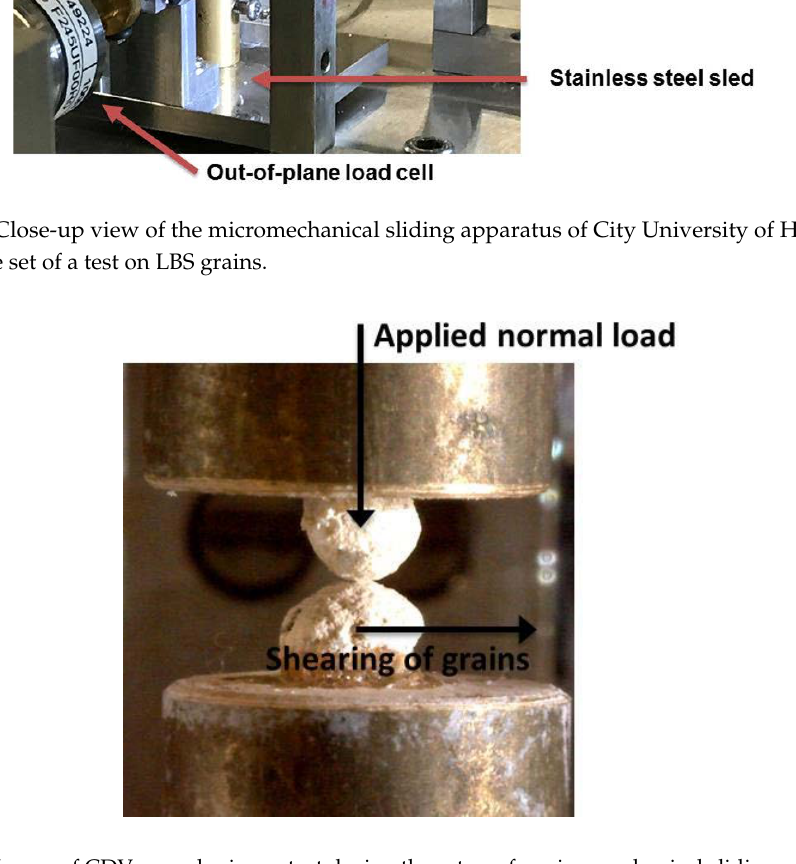
Figure 6. Image of CDV granules in contact during the setup of a micromechanical sliding experiment.